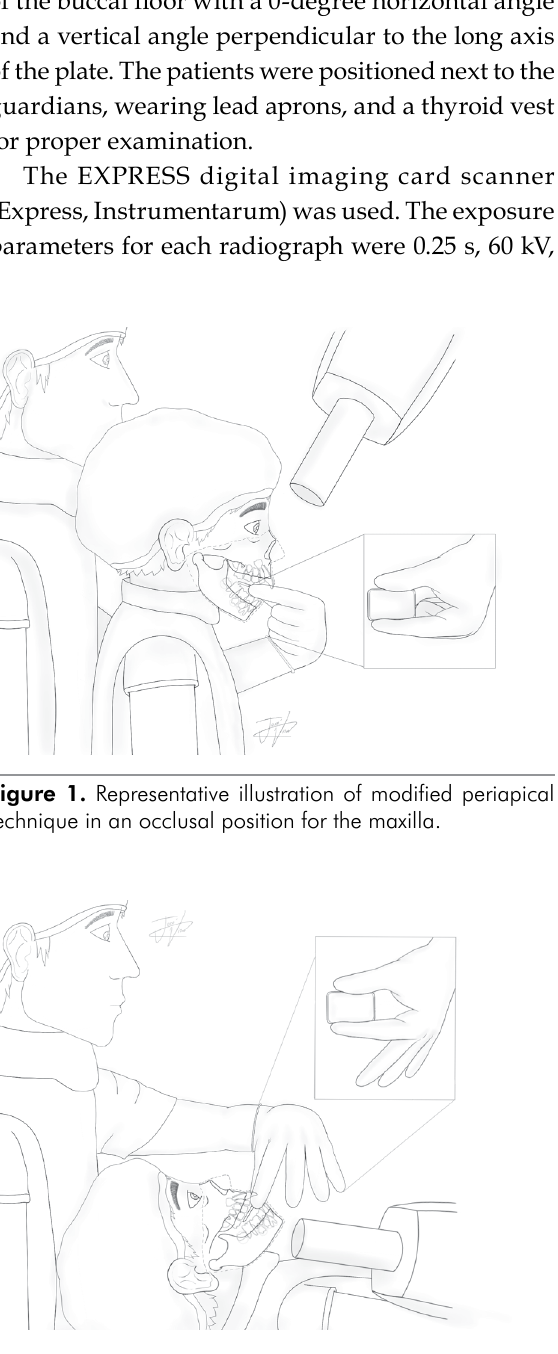
Figure 2. Representative illusttration of modified periapical technique in an occlusal position for the mandible.